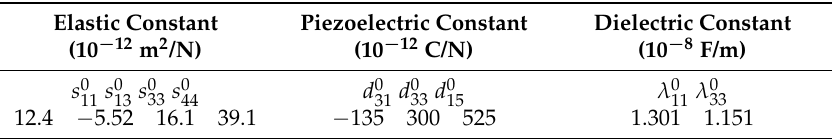
Table 1. Elastic, piezoelectric, and dielectric constants of the cantilever beam at z = 0.